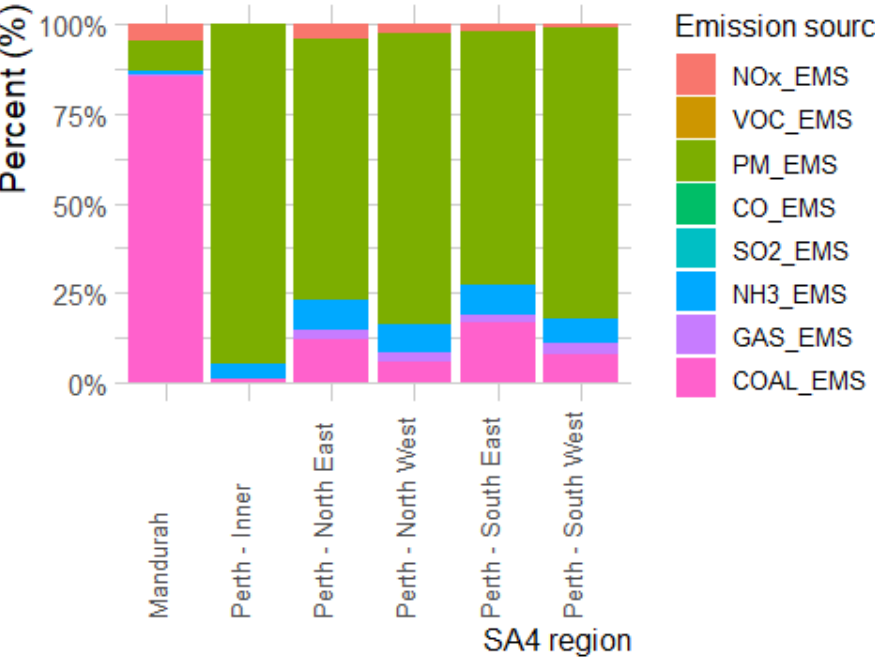
Figure 6. Percentage contribution to ∆ PM 2.5 variance by SA4 region within GMR Perth.